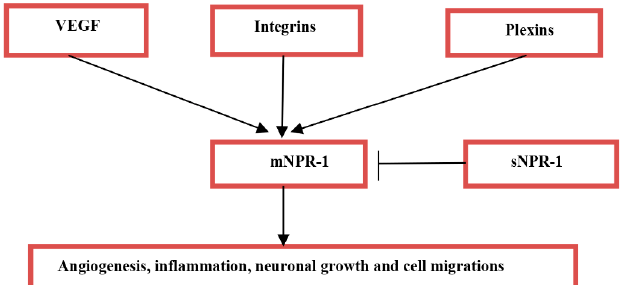
Figure 2. The legends of neuropilin-1 receptors (NRP-1): Vascular endothelial growth factor (VEGF), integrins, and plexins activate membrane-bound NRP-1 (mNPR-1) leading to angiogenesis, inflam- mation, and neuronal growth and cell migrations. Though, soluble NPR-1 (sNPR-1) inhibits action of mNPR-1.